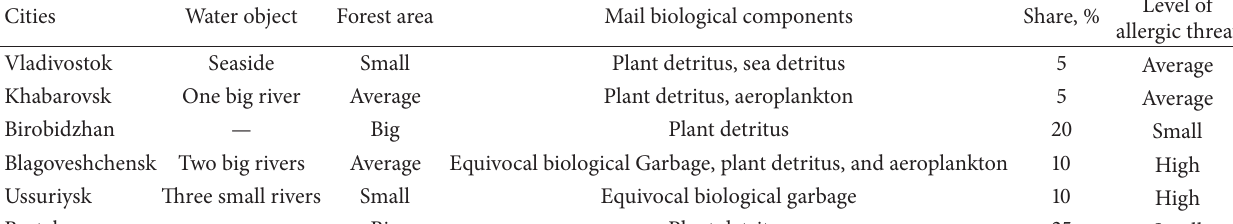
Table 1: Influence of different factors on structure of biological components of suspensions.